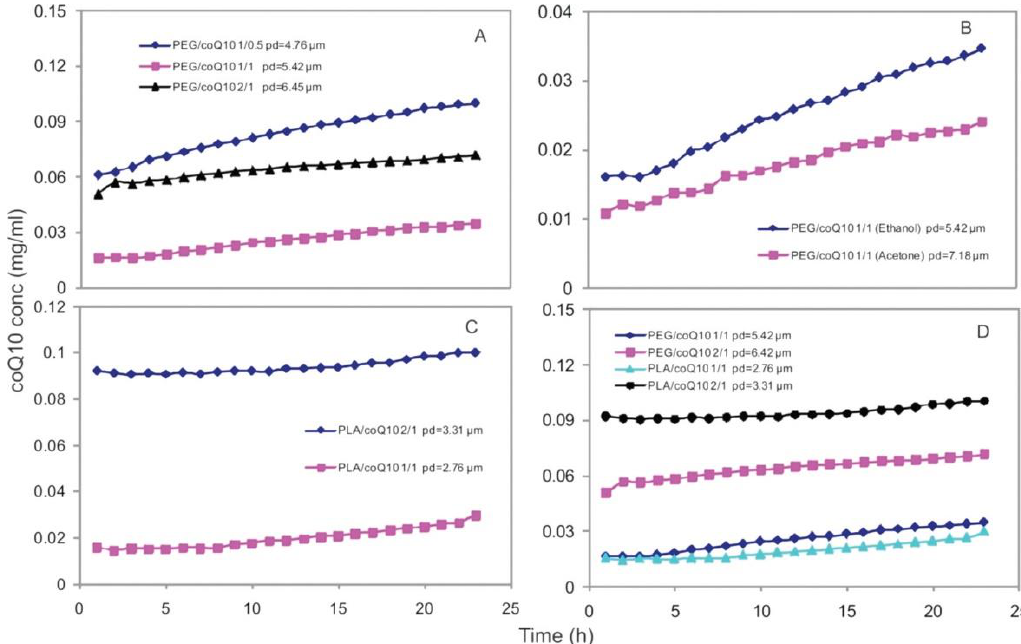
Figure 3. Drug dissolution kinetics, ( A ) the effect of the PEG/coQ10 ratio, ( B ) the effect of the co-solvent, ( C ) the effect of the PLA/coQ10 ratio, and ( D ) a comparison of PEG and PLA [38]. Reprinted with permission from M.d.S. Vergara-Mendoza et al., Microencapsulation of Coenzyme Q10 in Poly(ethylene glycol) and Poly(lactic acid) with Supercritical Carbon Dioxide, Industrial & Engineering Chemistry Research 51(17) 5840 – 5846, Copyright 2012, American Chemical Society.